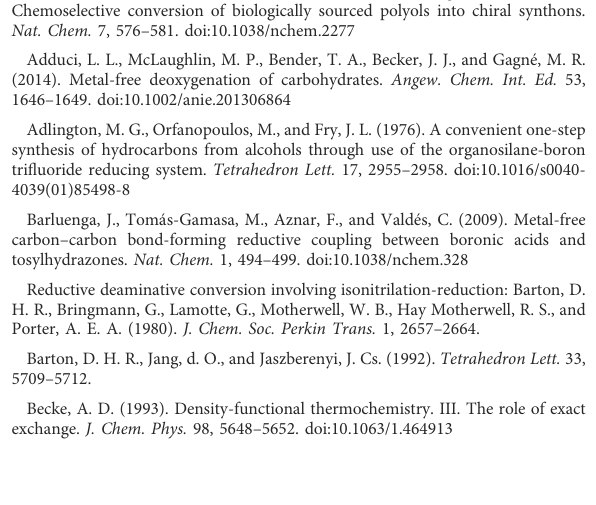
SUPPLEMENTARY FIGURE S2 Frontiermolecularorbitalanalysisof1a,B(C6F5)andPhSiH3(top)andthe NCI surfaces of int1 and int11 (bottom). SUPPLEMENTARY FIGURE S3 The formation of int12 and int13. SUPPLEMENTARY FIGURE S4 Gibbs energy pro fi le for the structural rearrangement between int2 and int4. SUPPLEMENTARY FIGURE S5 Gibbs energy pro fi le for the structural rearrangement between int6 and int8. SUPPLEMENTARY TABLE